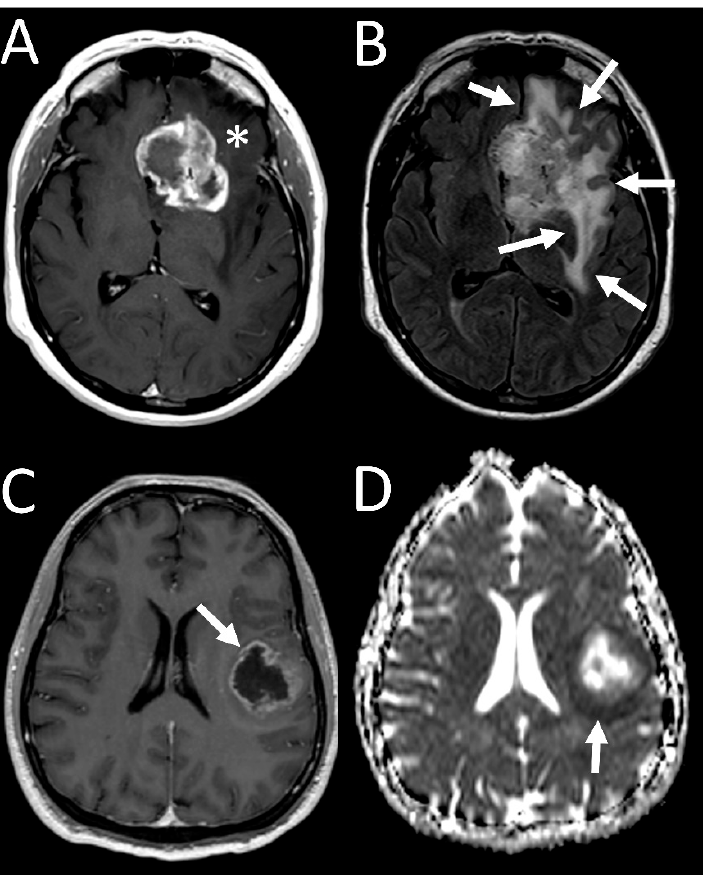
Figure 1. Sample imaging features of glioblastoma with 19/20 co-gain. ( A ) T1 postcontrast image of left frontal tumor demonstrating avid enhancement (asterisk), with ( B ) FLAIR image showing a large area of surrounding edema (arrows). ( C ) T1 postcontrast image of another tumor shows thinner rim of enhancing tumor (arrow), with ( D ) ADC map showing an area of non-enhancing, diffusion-restricting tumor beyond the enhancing tumor (arrow).